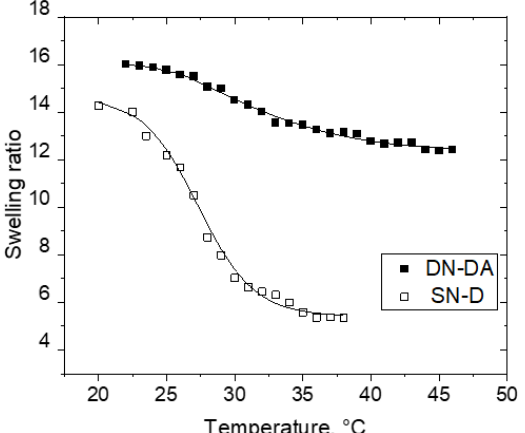
Figure 1. Temperature dependence of the swelling ratio for the SN-D and DN-DA hydrogels.